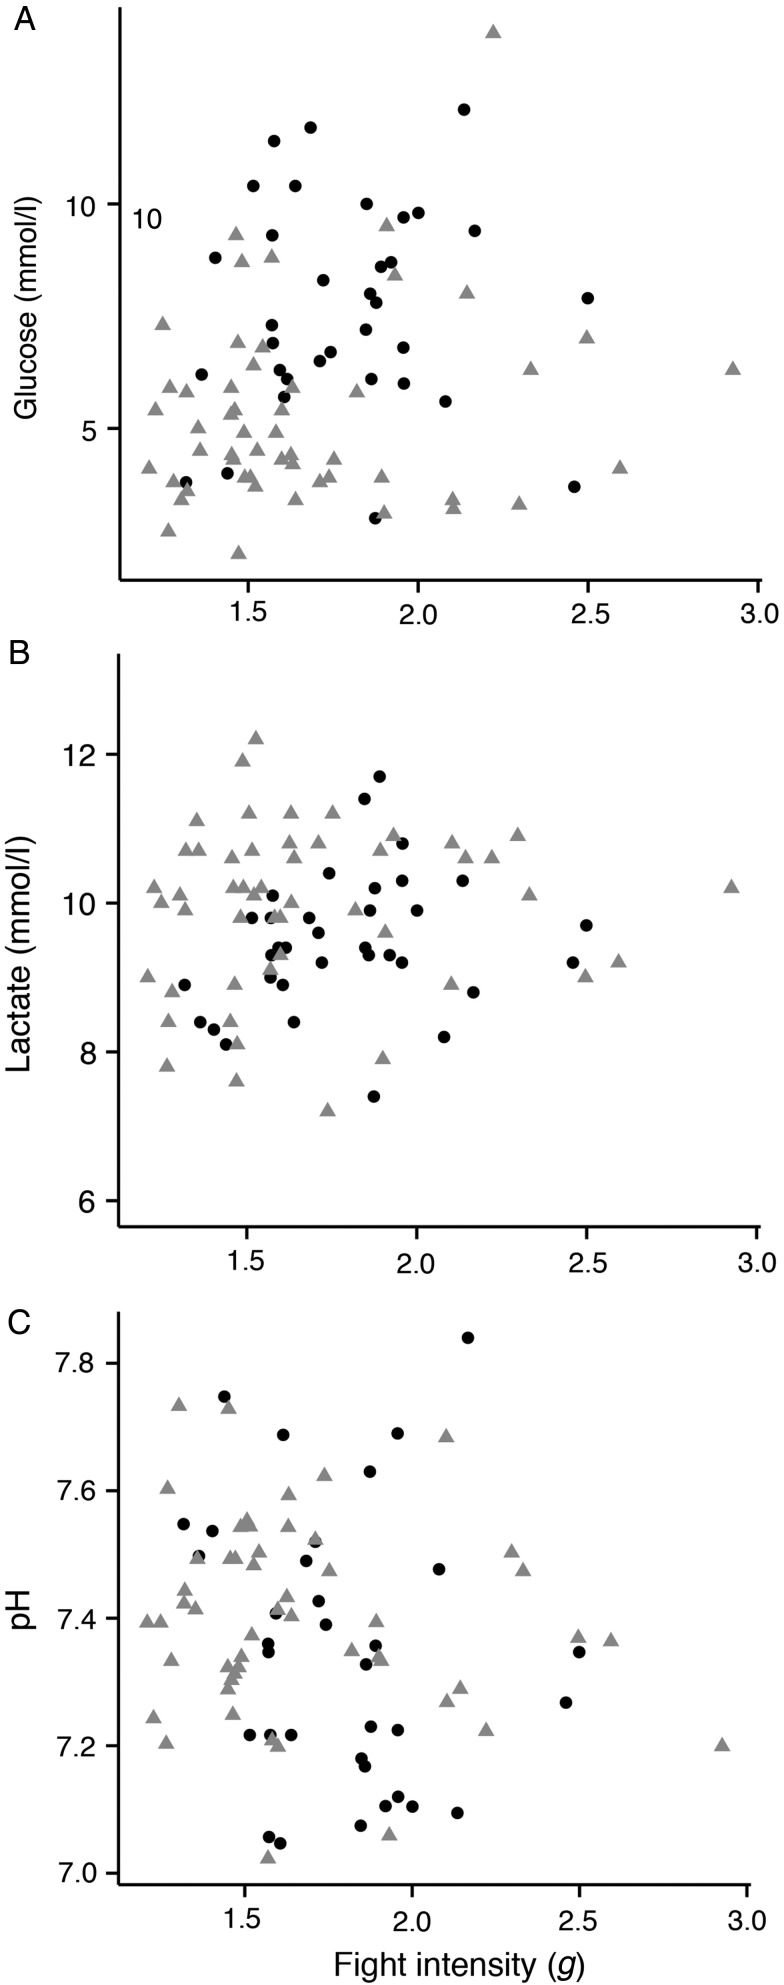
Relationship between average fight intensity and (A) blood glucose (mmol/l), (B) blood lactate (mmol/l), and (C) blood pH at 12°C (black dots) and 22°C (grey triangles) 1 h after angling events.